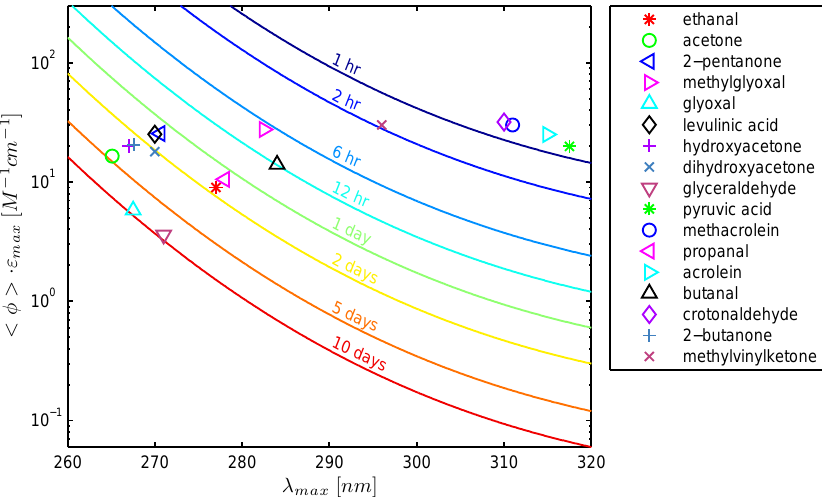
Fig. 4. Predicted aqueous photolysis lifetimes as a function of the wavelength of maximum absorbance of the carbonyl peak and the product of the average photolysis yield and the maximum extinction coefficient of said peak at a solar zenith angle of 20 ◦ . Marker positions are determined by experimental values of λ max and ε max . Note that, in the case of methylglyoxal (Staffelbach et al., 1995) and glyoxal (Horowitz et al., 2001), the 425nm band, which is assumed not to contribute to photolysis in water, will potentially reduce photolysis lifetimes compared to the values represented in the figure.